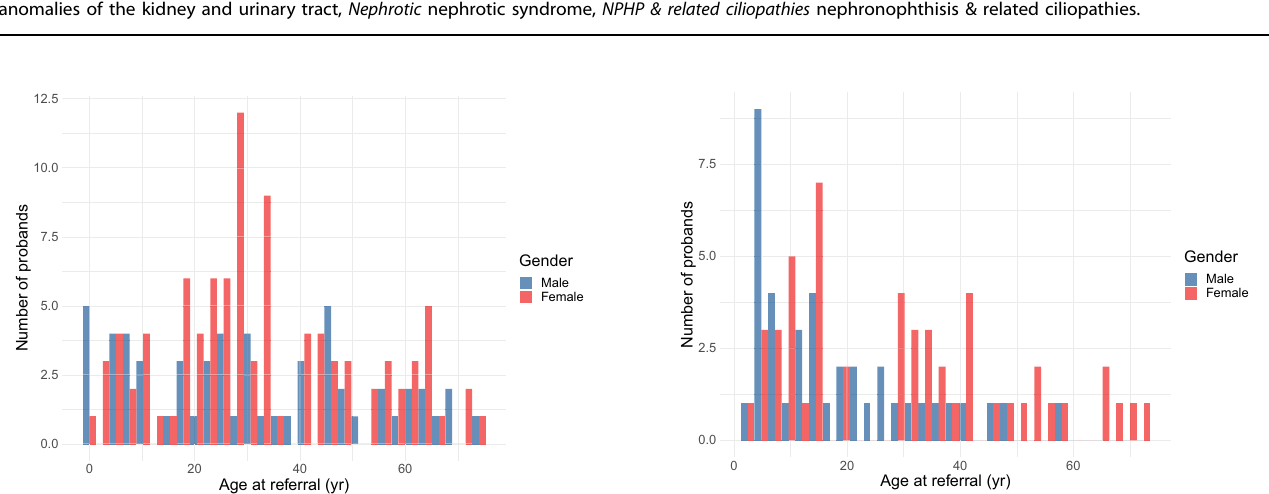
Fig. 3 Age and gender distribution of 90 probands referred for Alport syndrome panel testing. Referrals were processed between December 2013 and October